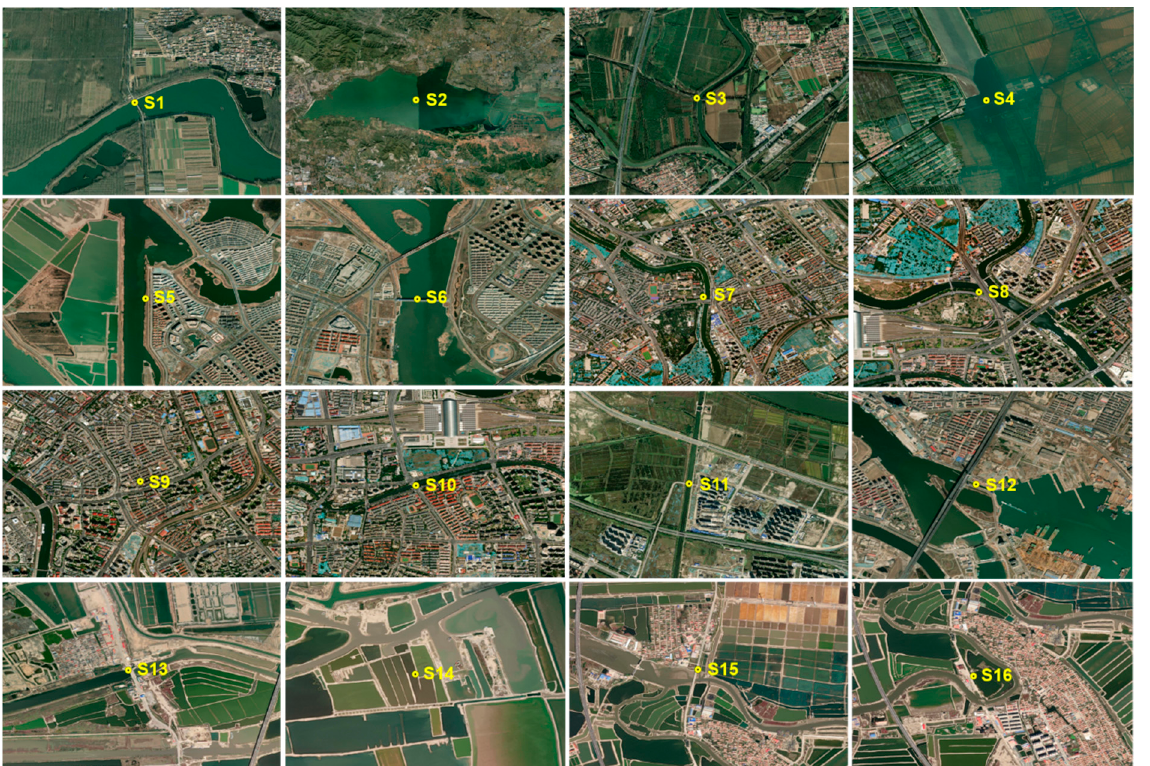
Figure 6. The LULC pattern around Tianjin water quality monitoring stations. S1–S16 are water quality monitoring stations 1–16, respectively. quality monitoring stations 1–16,